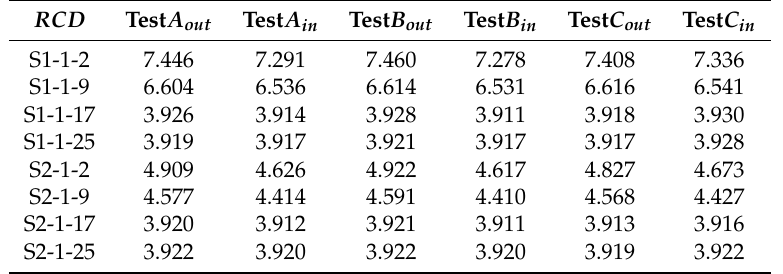
Table 2. Results of capacitance measurement (in pF) for selected electrode pairs and all testing phantoms. RCD Test A out Test A in Test B